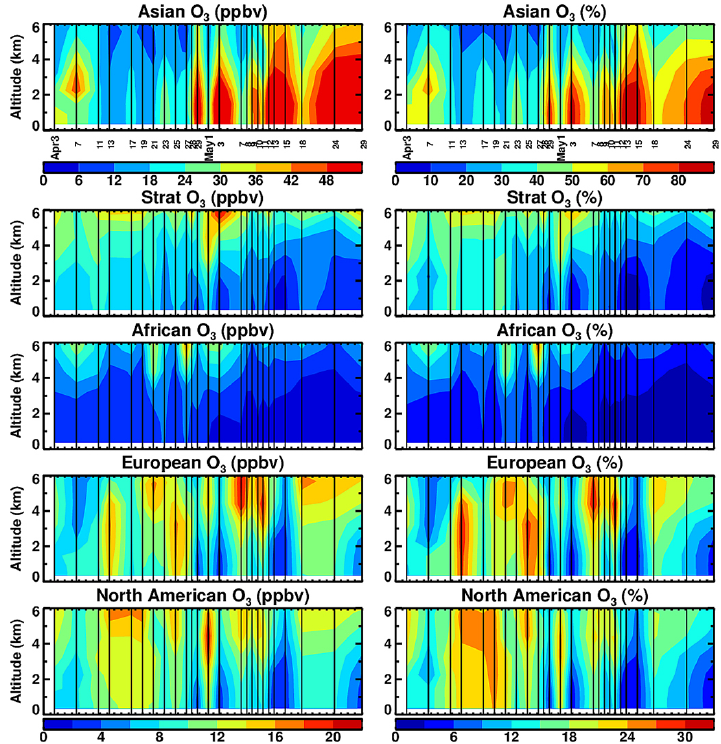
Figure 6. Major sources contributing to O 3 (0–6km) over Beijing, as simulated by GEOS-Chem driven by the GEOS-4 meteorological fields during April–May 2005. The plots show time–height cross sections of concentrations (ppbv, left panels) and percentages (%, right panels) of tagged O 3 produced in the Asian, African, European, and North American troposphere, as well as O 3 transported from the stratosphere. Model daily outputs are sampled at the location and dates (vertical lines) of ozonesonde soundings and/or aircraft measurements. Note the different color scales on color